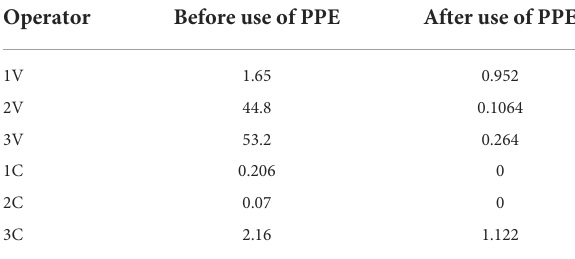
TABLE 6 Pesticide residues levels in hand washings ( µ g) among operators before and after use of PPE.